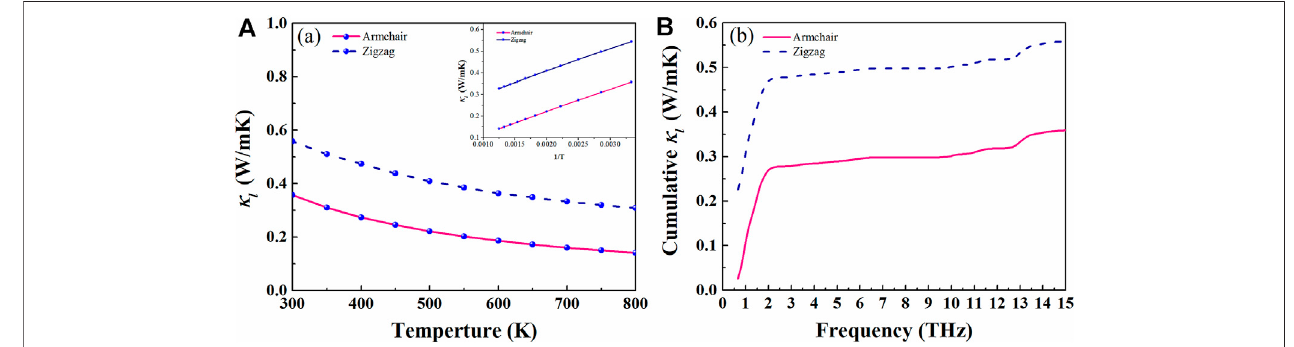
FIGURE 5 | Lattice thermal conductivity of AsP 3 as a function of temperature (A) and frequency (B) . The insets of (A) is lattice thermal conductivity as a function of T − 1 .